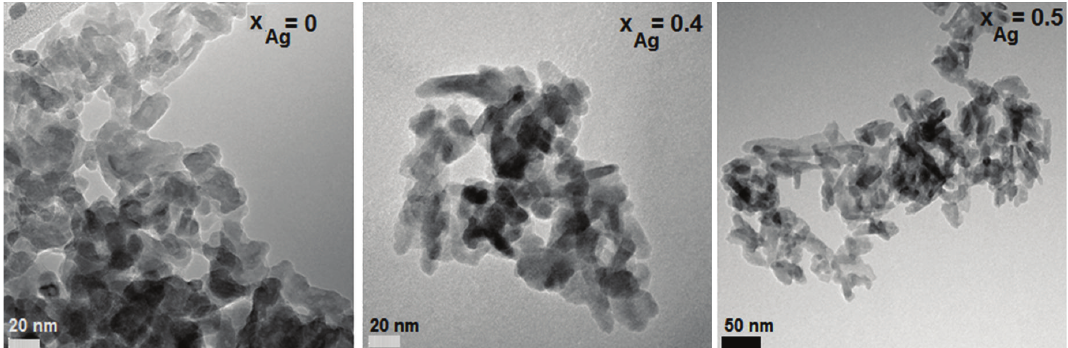
F 1: e TEM images of pure HAp (